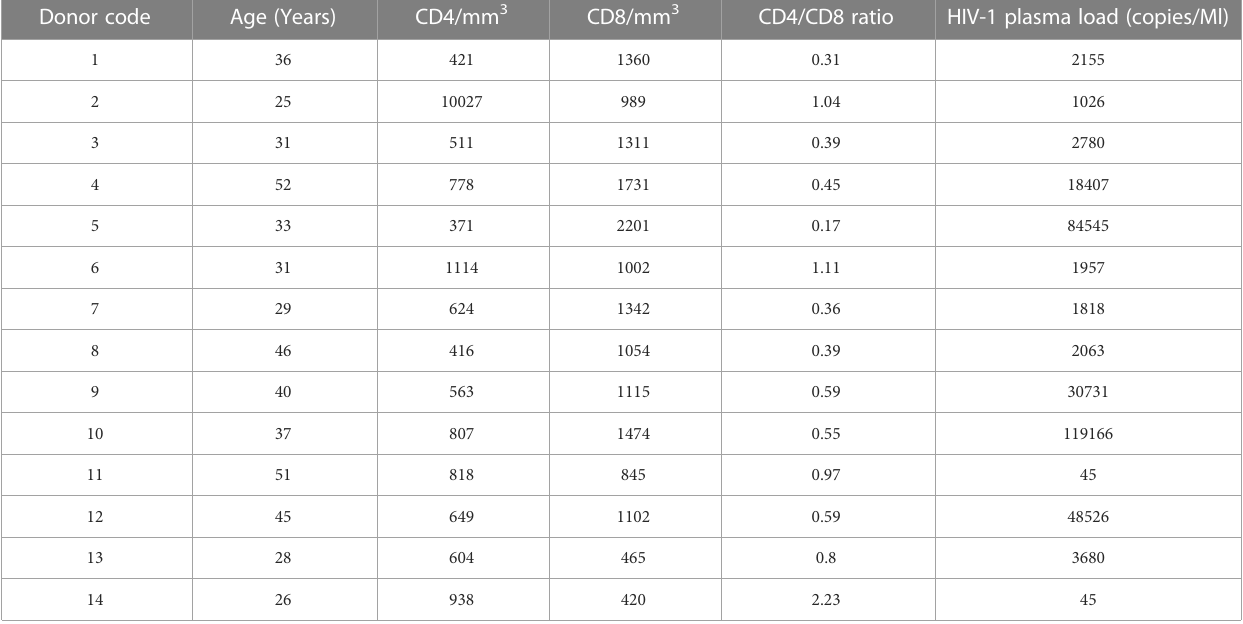
TABLE 1 Clinical parameters of HIV positive